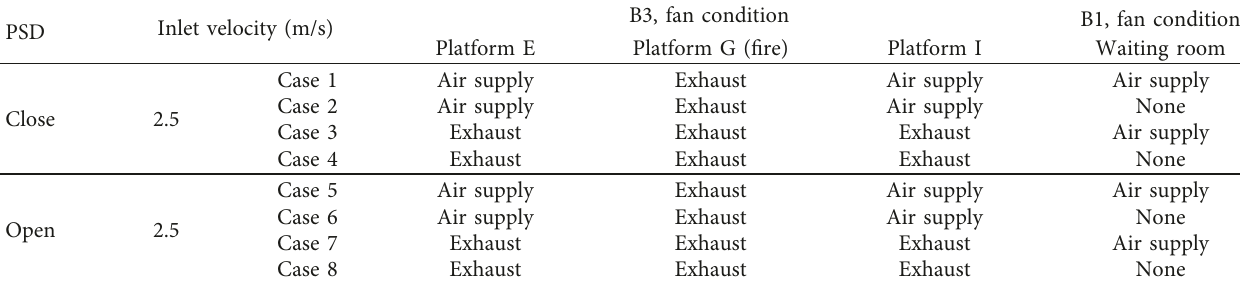
Table 1: PSD and fan